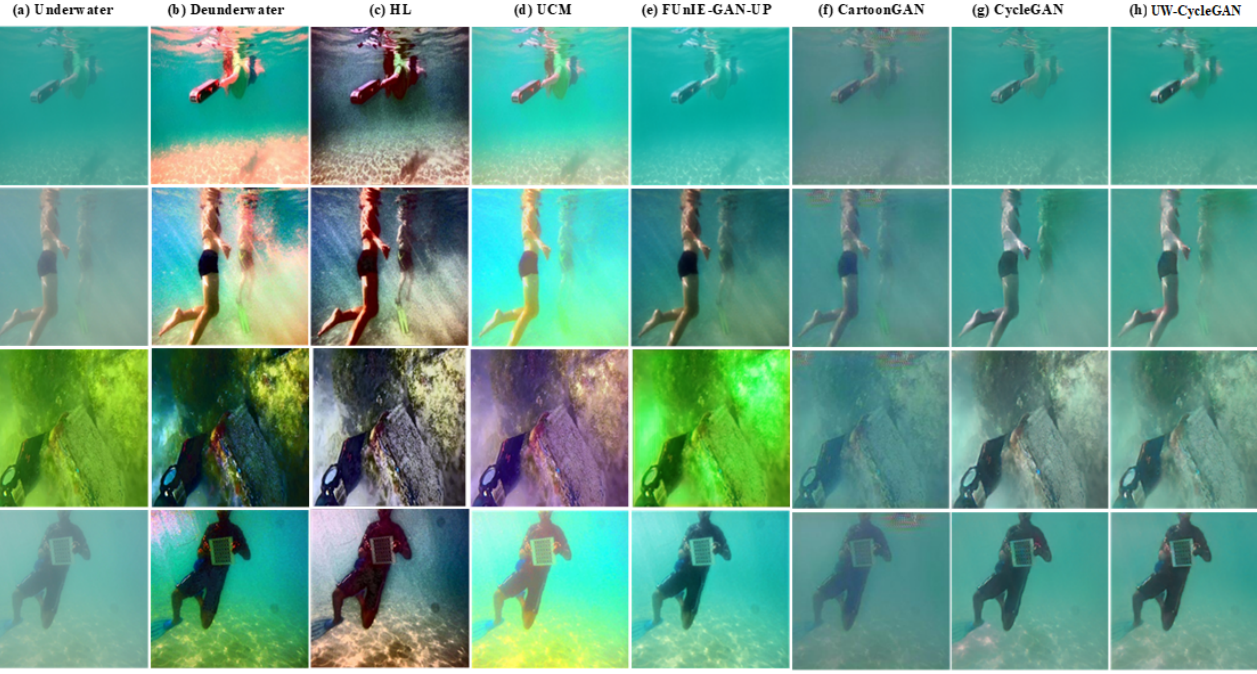
Figure 6. Visual quality comparisons of the enhanced underwater images on the EUVP